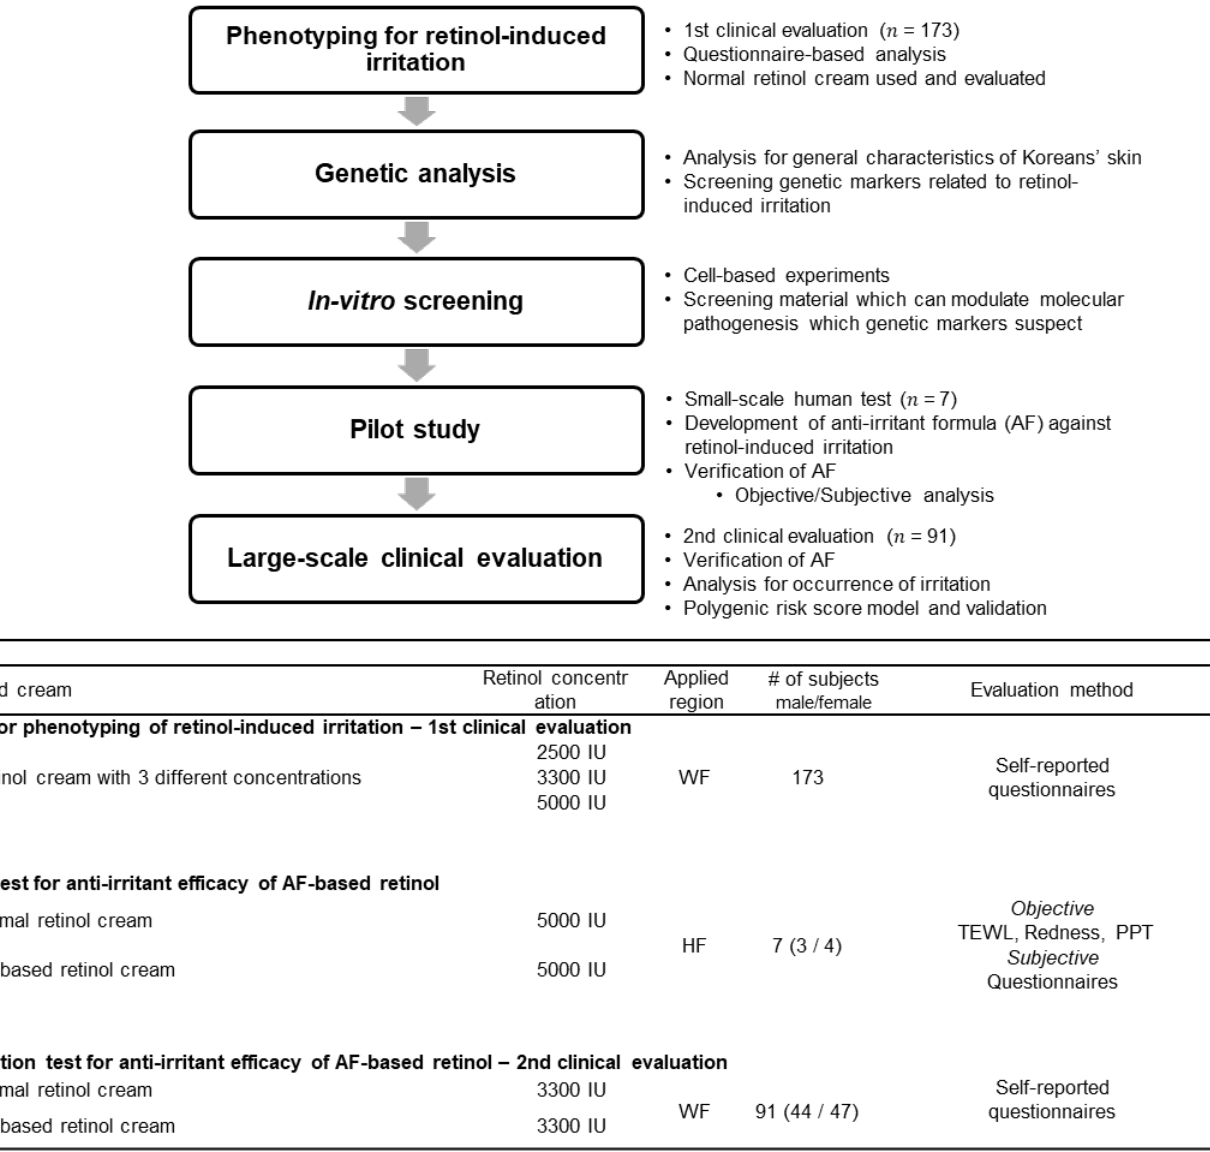
Figure 1. Study design. Upper diagram (flow chart) depicts the overall procedure of the study. The lower table indicates the main three human-based tests. Retinol 1 IU refers to 3 × 10 − 5 % w/w in the formulation. (2500 IU = 0.075% w/w ; 3300 IU = 0.1% w/w ; 5000 IU = 0.15% w/w ) .